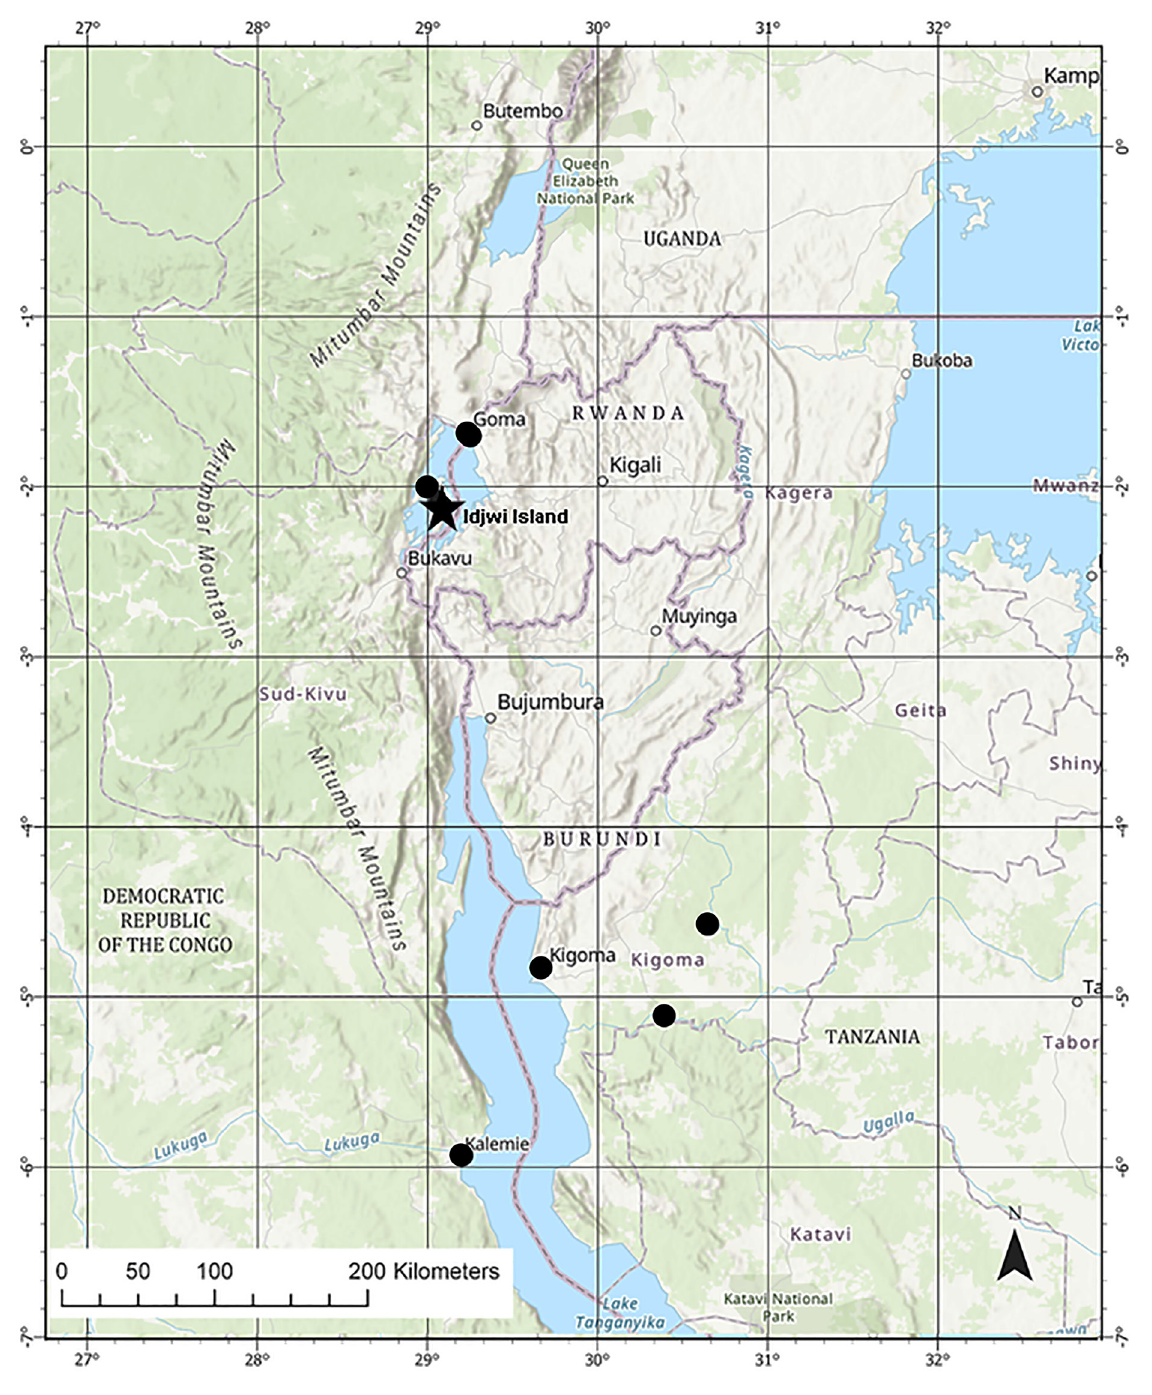
Fig. 3. Map showing the updated geographic distribution of Potamonautes amosae sp. nov. The black star shows the type locality. See text for exact